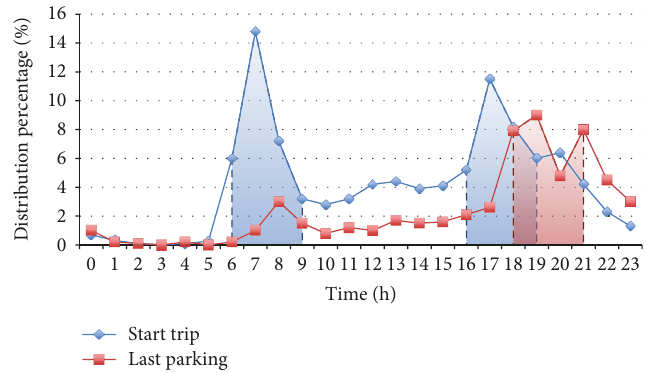
Figure 3: Daily traveling and parking behaviours of EVs in